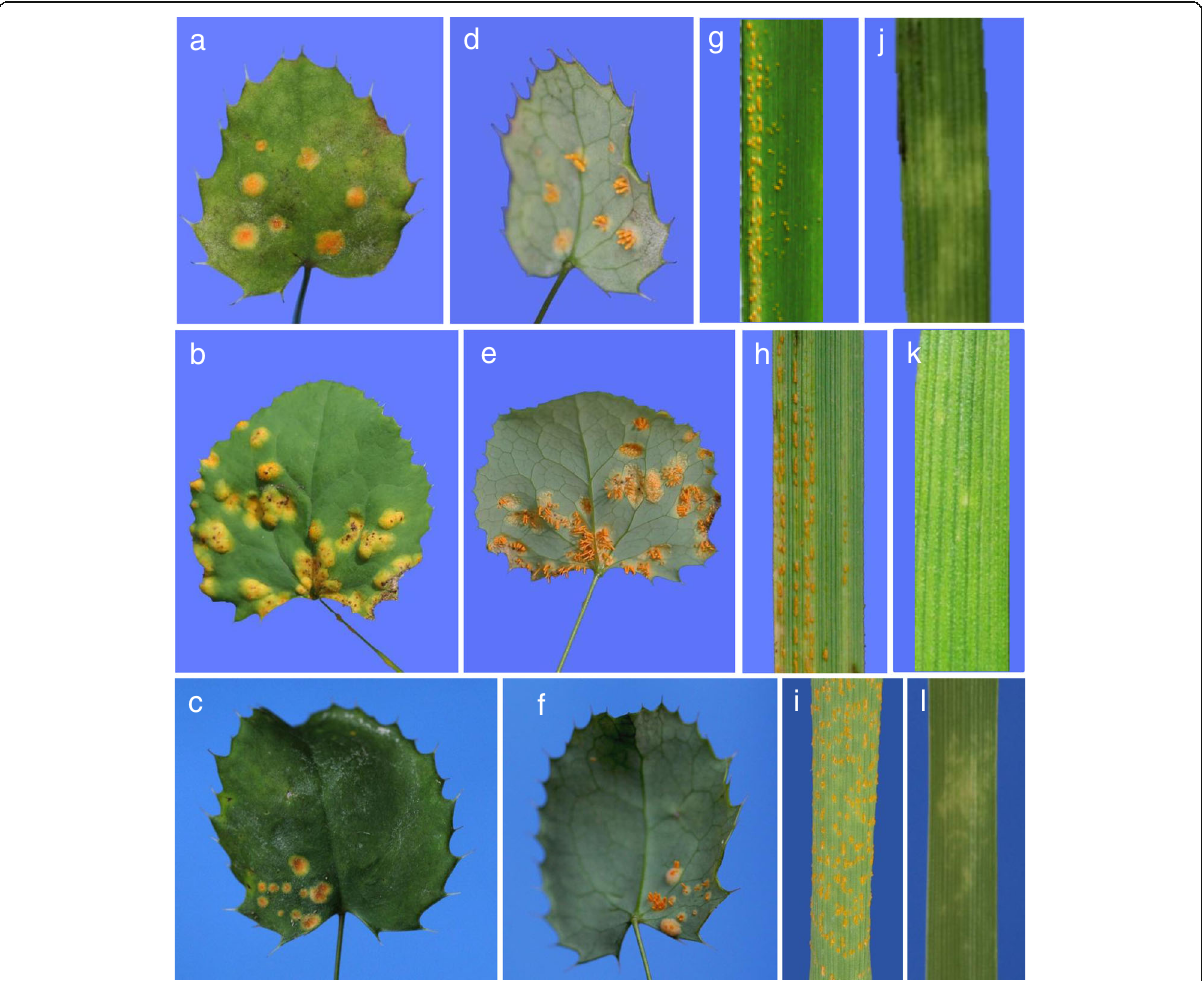
Fig. 4 Pycnial and aecial stages of each of formae speciales of Puccinia striiformis infecting Berberis . a , b , c Pycnial stage of Puccinia striiformis f. sp. agropyri , P. striiformis f. sp. elymi , and P. striiformis f. sp. hordei , on barberry ( Berberis shensiana ), respectively. d , e , f Aecial stage of P. striiformis f. sp. agropyri , P. striiformis f. sp. elymi , and P. striiformis f. sp. hordei , on barberry ( B. shensiana ), respectively. g , h , i Aeciospore infections of the three formae speciales of P. striiformis on respective original hosts, Elymus cylindricus , Agropyron cristatum , and barley cv. Guoluo ( Hordeum vulgare var. nudum ), after inoculation, respectively. j , k , l Reaction of wheat cv. Mingxian 169 seedlings inoculated with aeciospores of each of the three